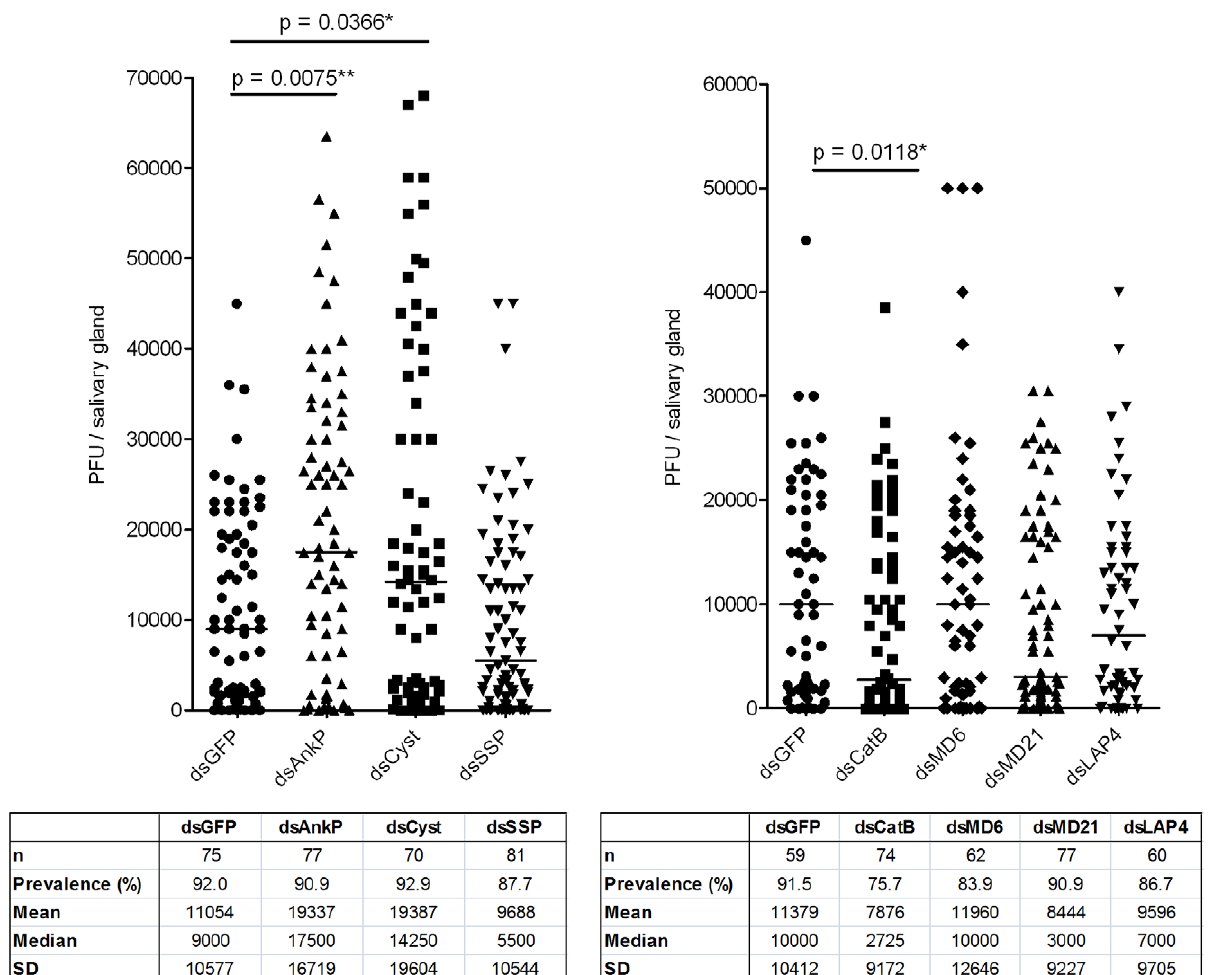
Figure 2. Effect of candidate gene knockdown on salivary gland DENV titers. Candidate genes were silenced in DENV-infected mosquitoes, and salivary gland virus titers at 14 dpbm were determined by plaque assay. A pool of three biological replicates is shown, and p values were determined using the Mann-Whitney U test (*, p , 0.05). Gene name abbreviations: AnkP, ankyrin repeat-containing protein; Cyst, cystatin; SSP, salivary secreted peptide; CatB, cathepsin